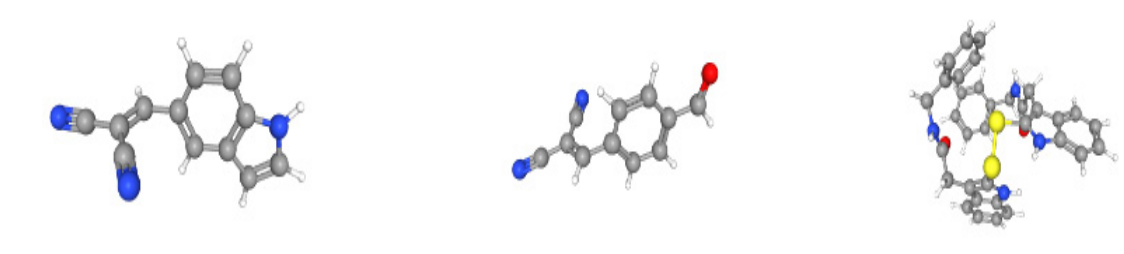
Figure 2. A 2D molecular diagram of the top three compounds.